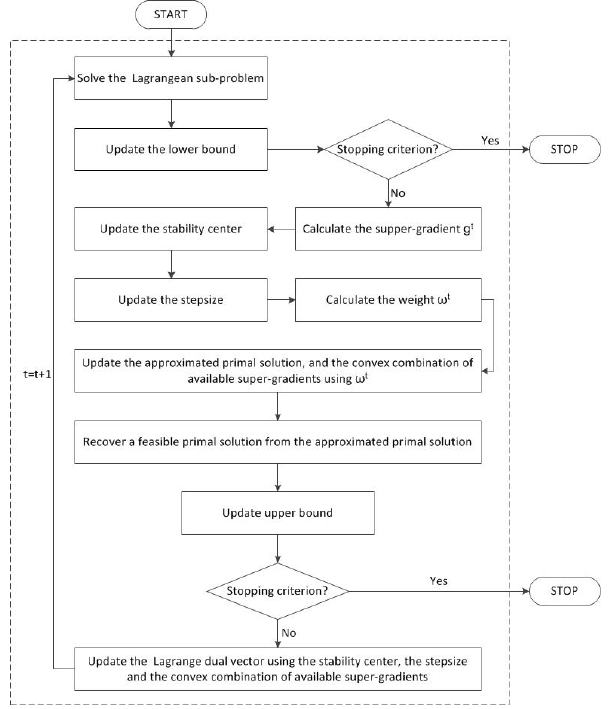
Figure 2. Flow chart of the Lagrangian